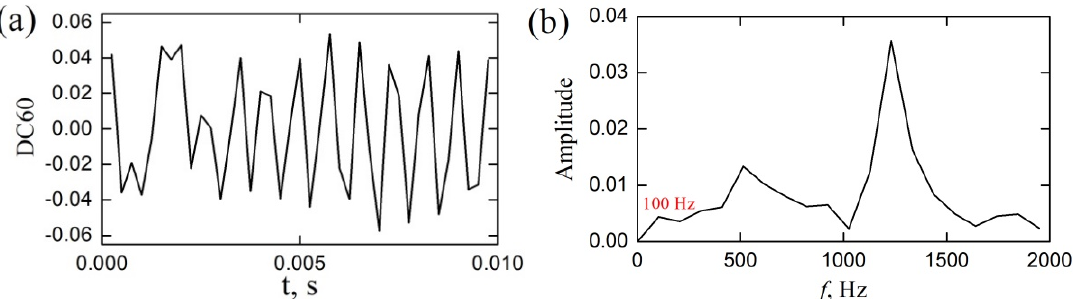
Figure 12. ( a ) The unsteady fluctuation and ( b ) the spectrum of the total pressure recovery at the AIP.